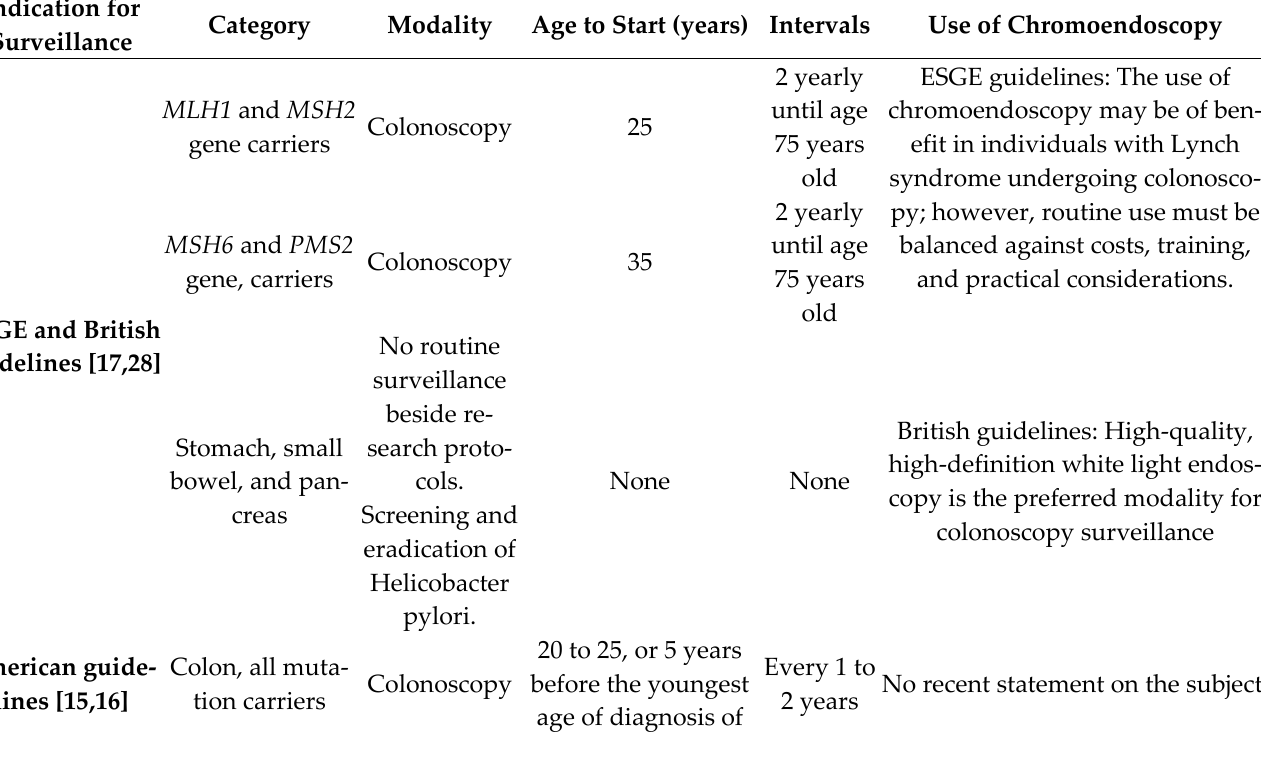
Table 5. Summary of follow-up guidelines in Lynch syndrome